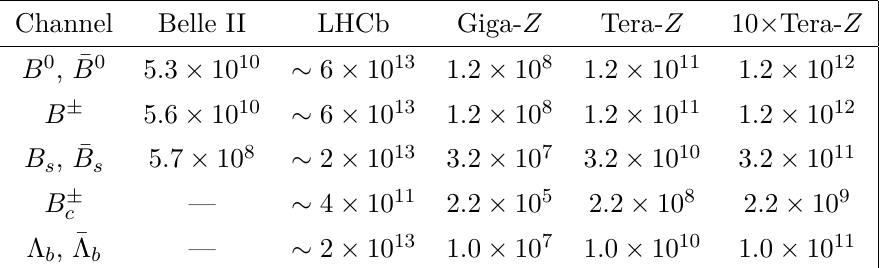
¯Λ ¯ are taken as the average suggested in [6]. As B s and Λ b / s / b ¯Λ and Λ productions due to the limitation of b / b c